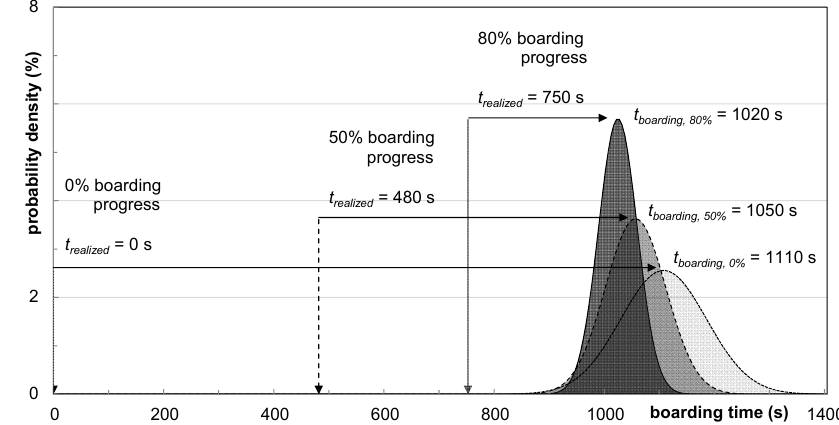
Figure 16. Evaluation of boarding time distribution during the aircraft boarding based on boarding progress of 0%, 50%, and 80%.